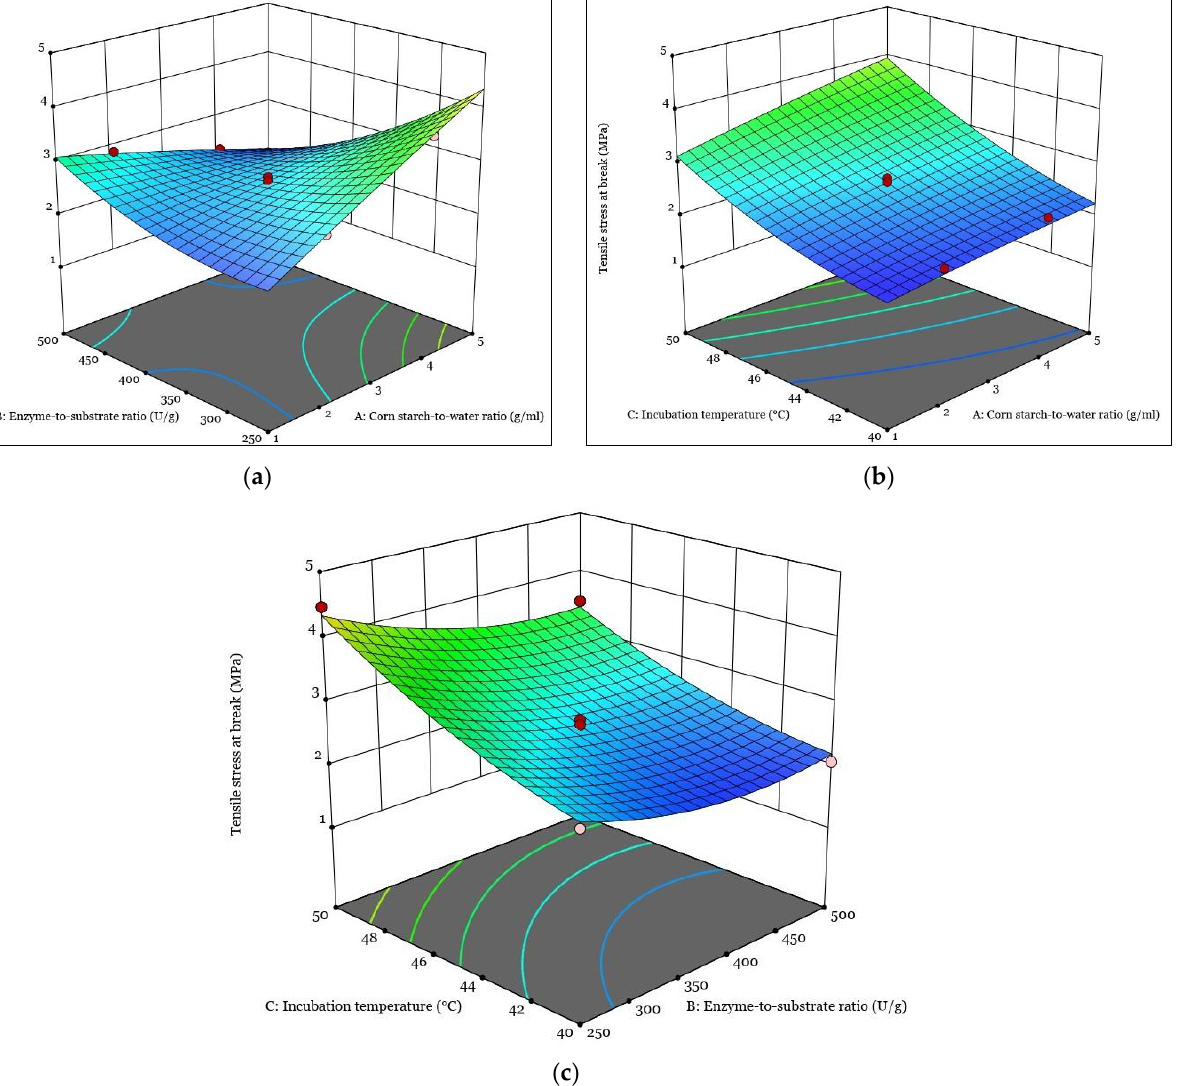
Figure 3. The response surfaces plots of the quadratic and 2FI polynomial models representing the influence of the interaction between independent variables on the tensile stress at break: ( a ) interaction between A and B; ( b ) interaction between A and C; ( c ) interaction between B and C.